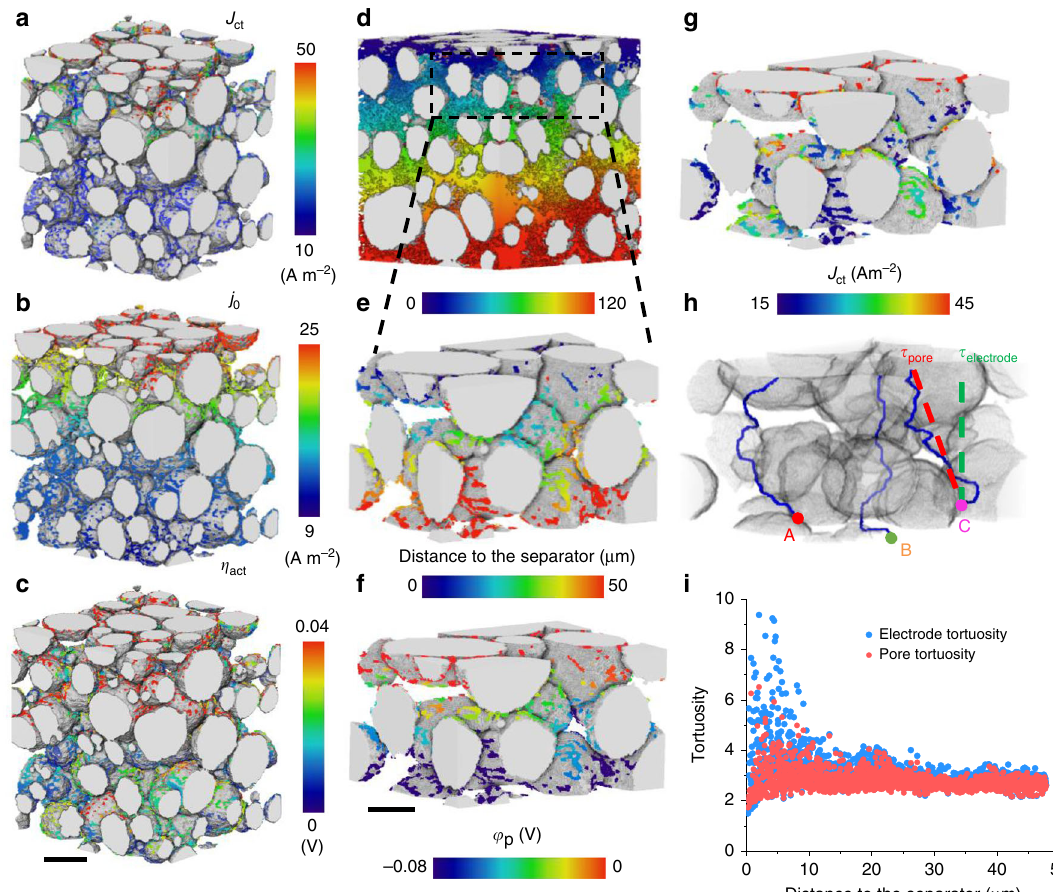
Fig. 5 Heterogeneous charge transfer analysis. Spatial distribution of a charge transfer current density J ct ; b exchange current density j 0 ; c activation overpotential η act ; d distance map of every single voxel in the pore phase to the nearest electrode/separator interface measured by a 3D fast marching algorithm; e travel distance of the lithium ion to the reaction sites is well correlated with f the potential drop in the electrolyte ( φ p ), which is consistent with g the local variation of charge transfer current density J ct . h Illustration of the tortuosity in the pore phase τ pore and electrode τ electrode respectively. A, B and C exemplify three distinctly convoluted pathways for Li + ion fl ow; i plot of τ electrode and τ pore as a function of distance from the separator. The scale bars in ( c ) and ( f ) represent 10 and 7 μ m,